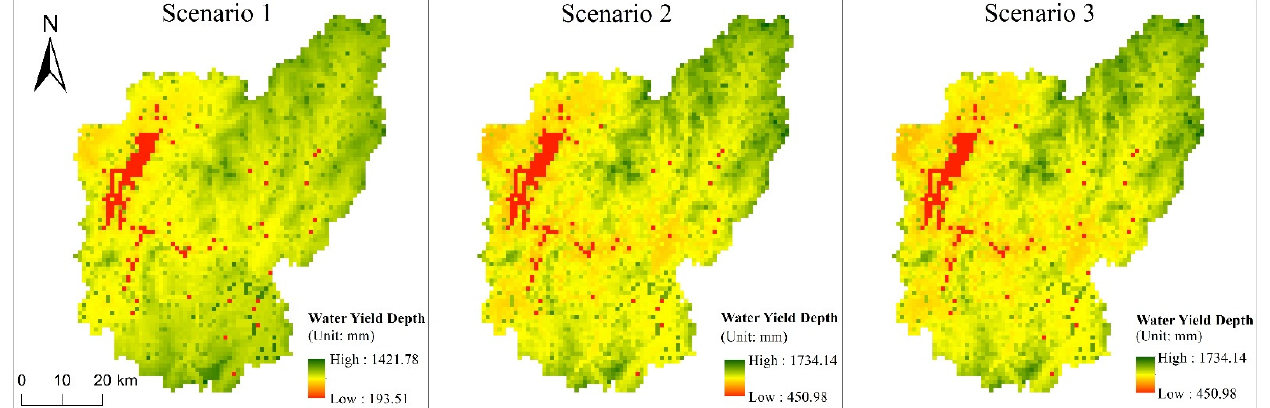
Figure 6. Water yield pattern of Dongjiang Lake Basin with LULC unchanged.